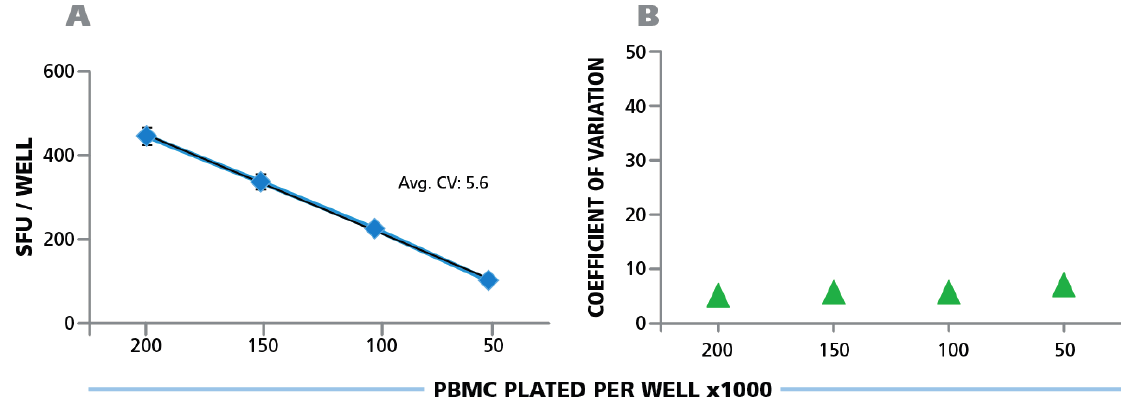
Figure 5. Hardware-dependent variability of ELISPOT counts generated on different ImmunoSpot® Readers. The physical Reference Plate was sent to the nine participating